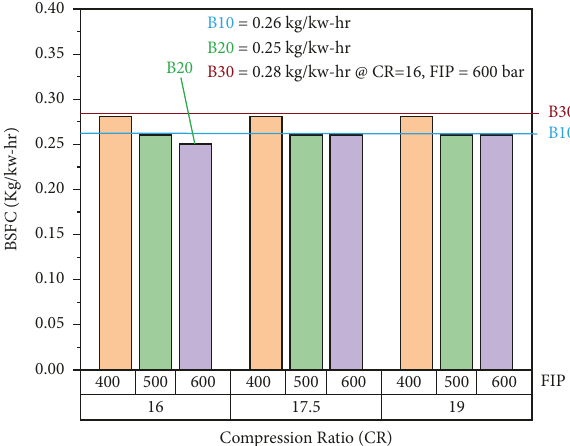
Figure 7: BSFC for B20 blend at various FIP and